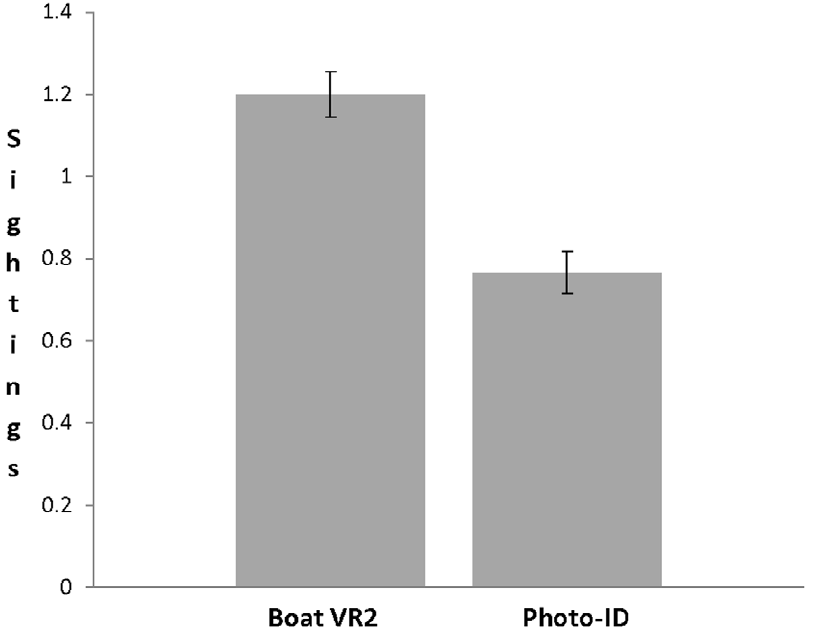
Figure 1. The average number of tagged white sharks detected (‘‘sightings’’) per day by the two different sampling approaches: photo-ID and a VR2 acoustic receiver deployed from a boat. Values are means 6 SE (n=60 replicates).